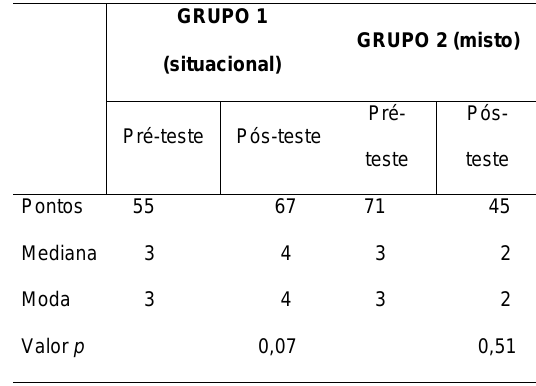
Tabela 5. Resultado do pré-teste e do pós-teste para conhecimento tático processual KORA: RE divergente